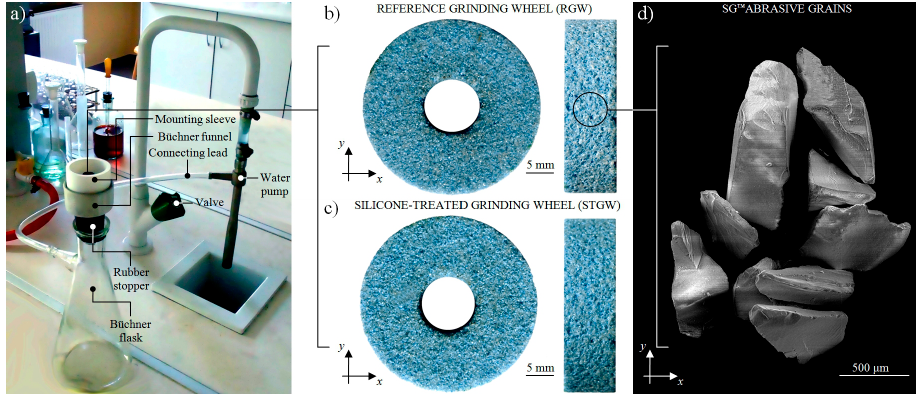
Figure 2. ( a ) Impregnation process of small-size grinding wheel 1-35×10×10SG/F46G10VTO by synthetic organosilicon polymer-based impregnate (silicone) under the reduced pressure conditions: general view of stand for realizing the impregnation process; ( b) general view of the non-treated RGW; ( c ) STGW after the impregnation process; ( d ) SEM micrograph presenting morphology of SG ™ abrasive grains (mag.: 50×, Ua = 20 kV, WD = 47 mm, spot size: 39, vacuum pressure: 8 Pa) [58].